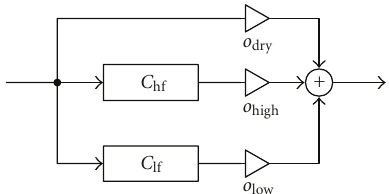
Figure 1: Block diagram showing high-level structure of the parametric spring reverberation model